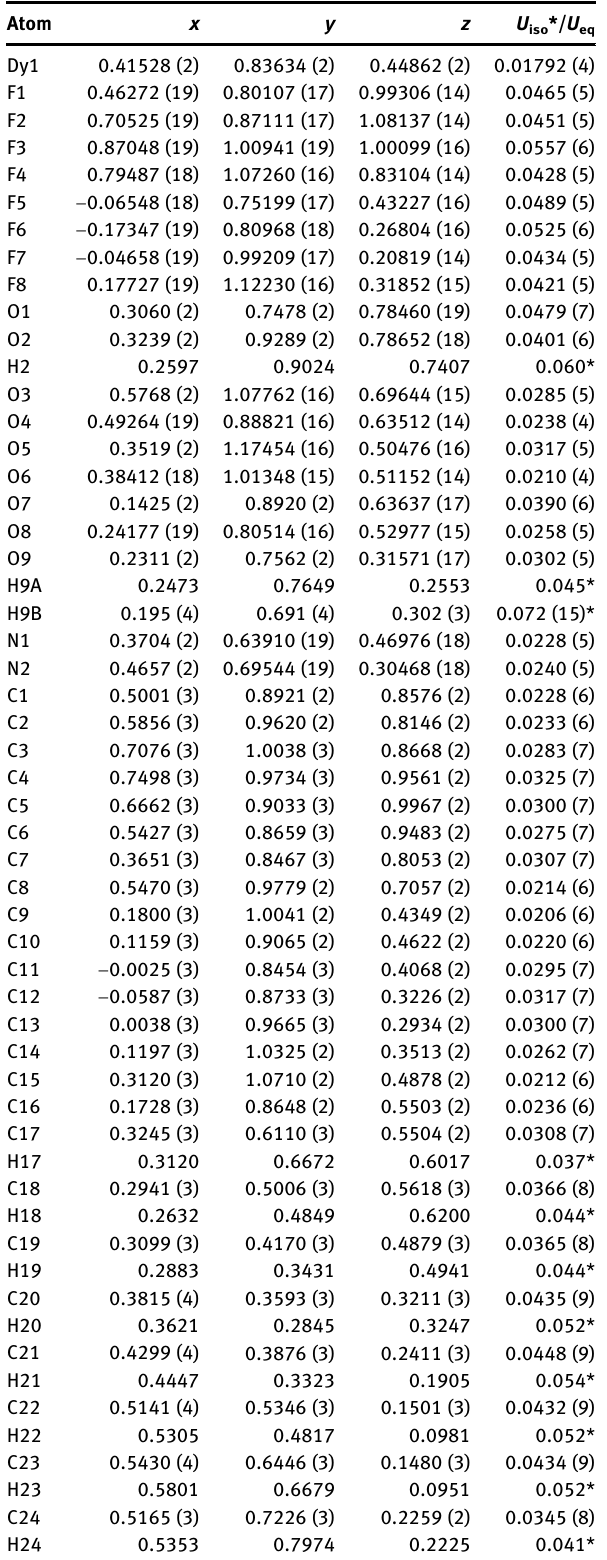
Table  : Fractional atomic coordinates and isotropic or equivalent isotropic displacement parameters (Å 